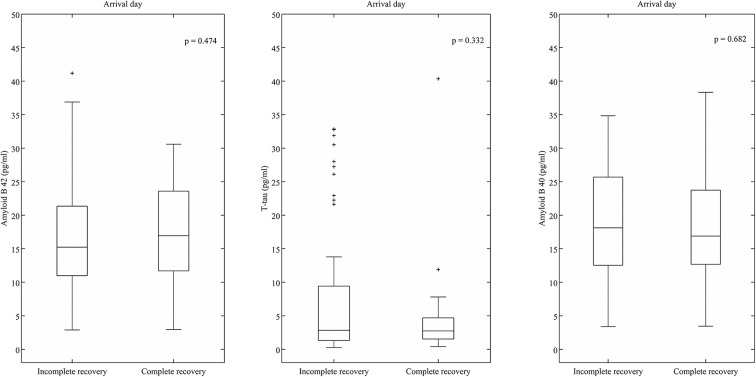
Levels of total tau (T-tau), β-amyloid isoform 1-40 (Aβ40), and β-amyloid isoform 1-42 (Aβ42) in patients with complete (GOS 8) and incomplete (GOS < 8) recovery (y axis is zoomed). Box plots represent medians in picograms per milliliter and interquartile ranges.